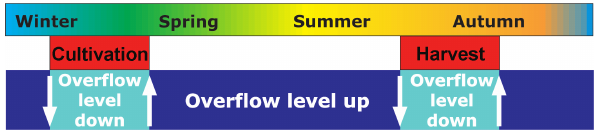
Figure 4. Drainage overflow level management schedule. The over- flow levels were elevated most of the time, but were lowered in early spring and, if needed, in autumn to accommodate manure applica- tion and